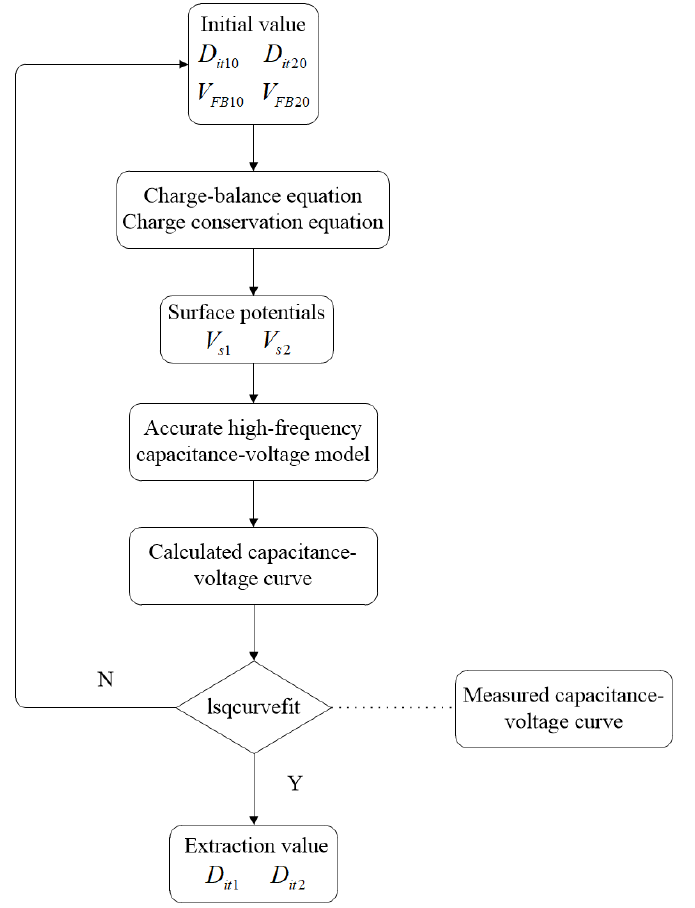
Figure 6. Flow chart of the extraction process of interface-trap densities in the stacked bonding structure.